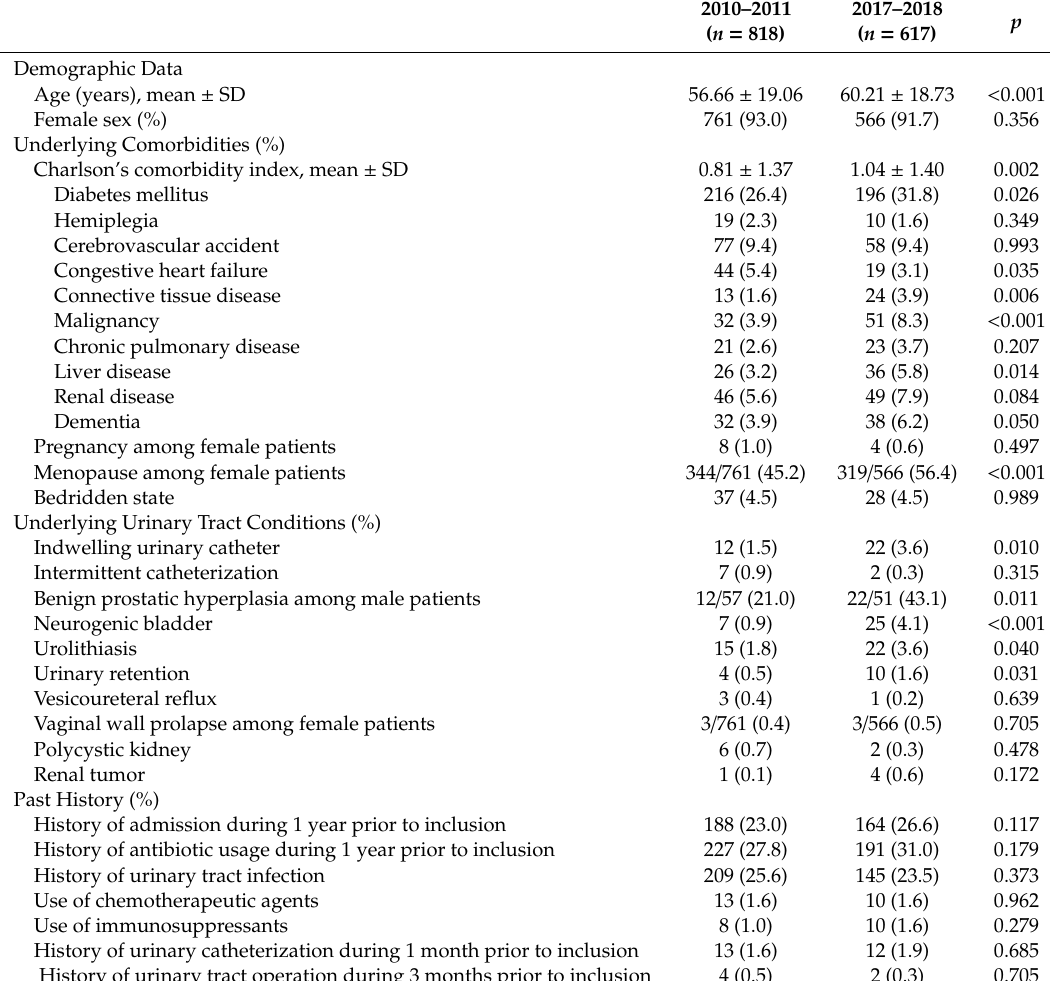
Table 3. Comparison of demographic data and risk factors among patients with community-acquired acute